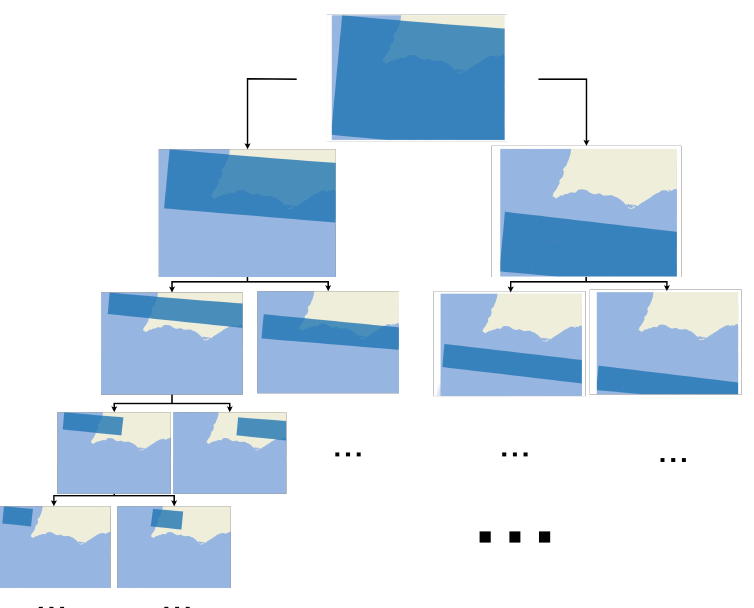
Figure 8. Example of a generated binary search tree.